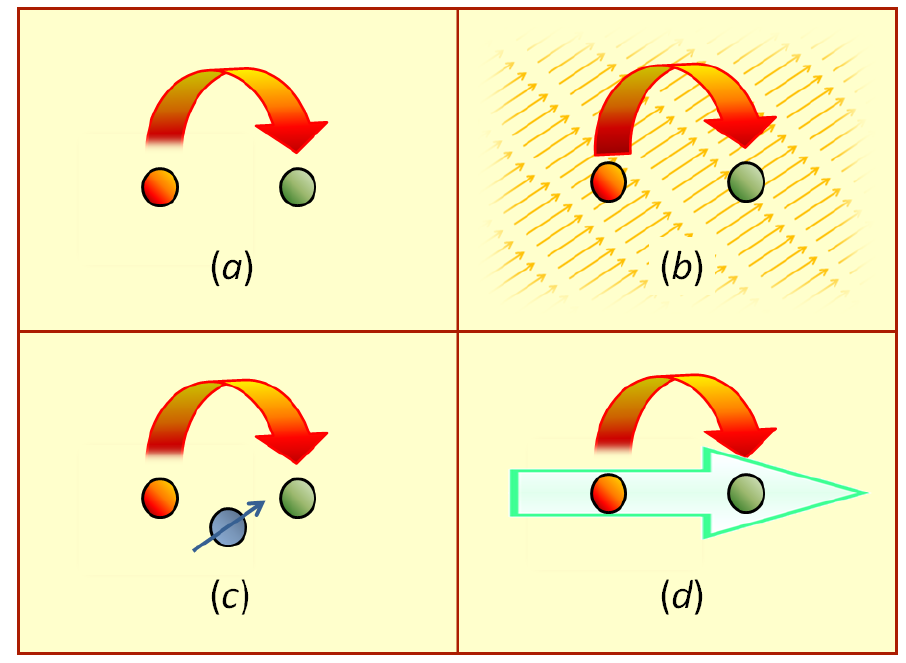
Figure 4. Schematic depictions of: ( a ) resonance energy transfer; ( b ) electric-field induced energy transfer; ( c ) third-body (dipole-assisted) energy transfer; ( d ) laser-assisted resonance energy transfer, the throughput beam being off-resonant with respect to the donor and acceptor